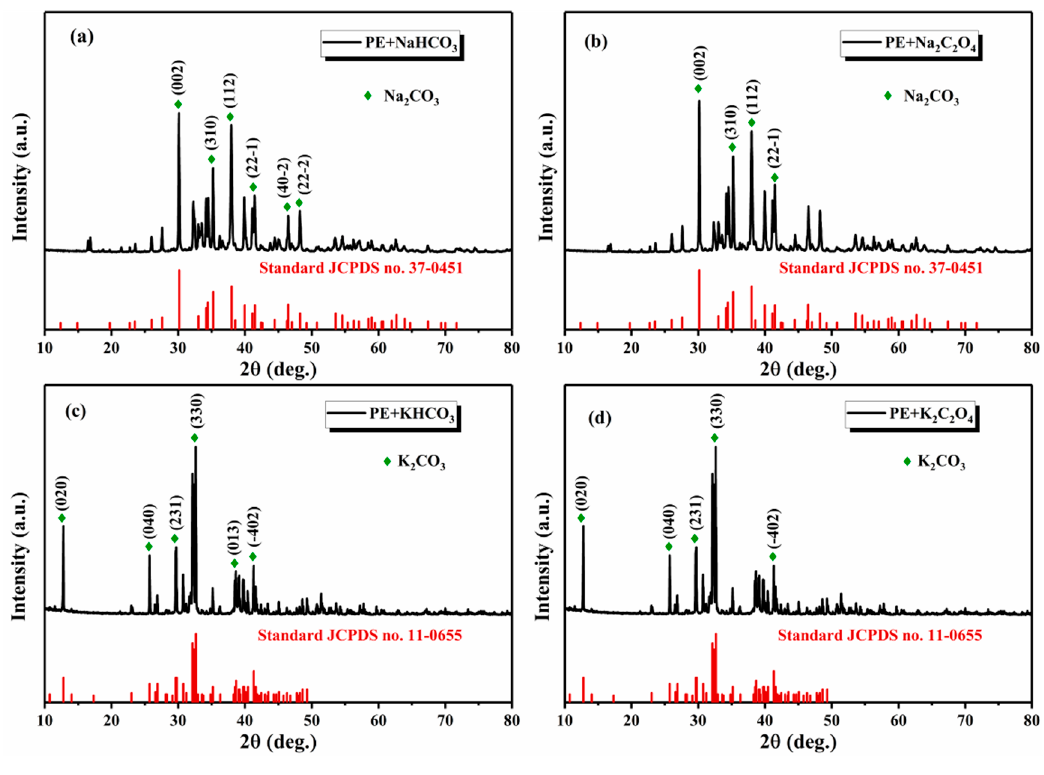
Figure 12. Product ingredient analyses of PE dust combustion after adding the four inert powders.